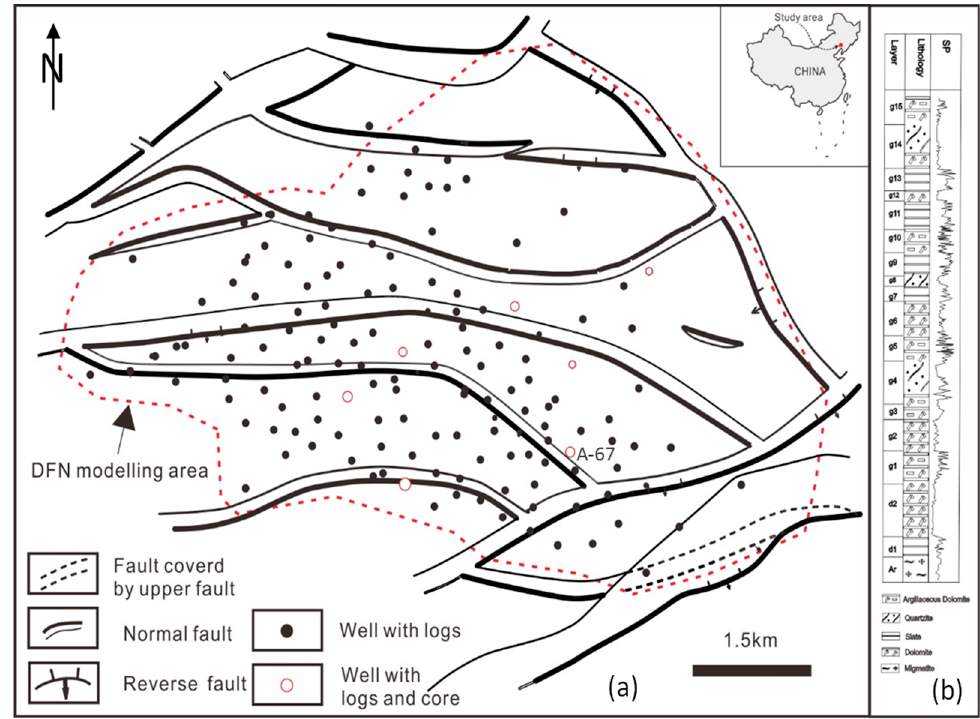
Figure 2. Locations of the Jingbei Oilfield and wells ( a ), and stratigraphy ( b ), in the study area.